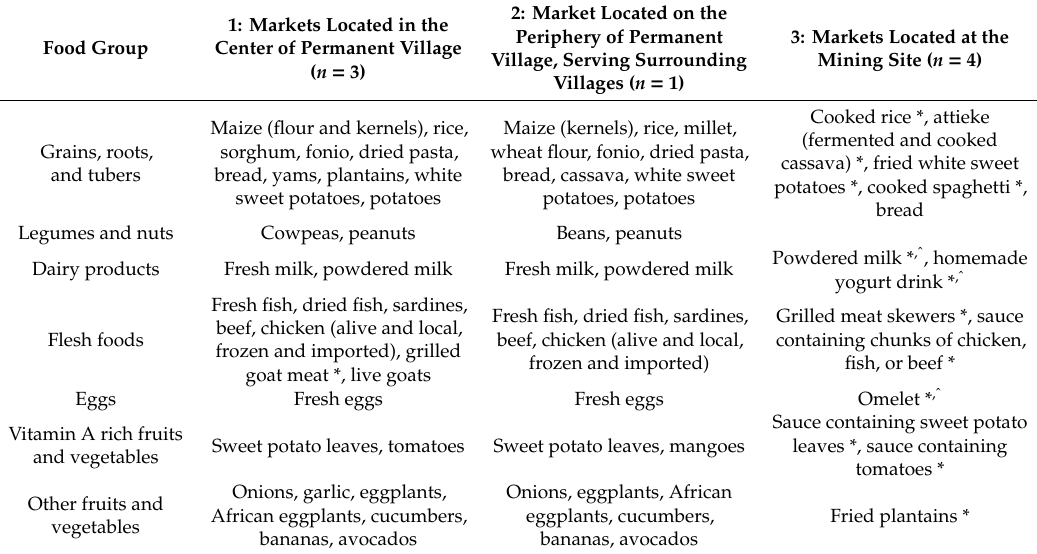
Table 4. Types of foods available by food group and